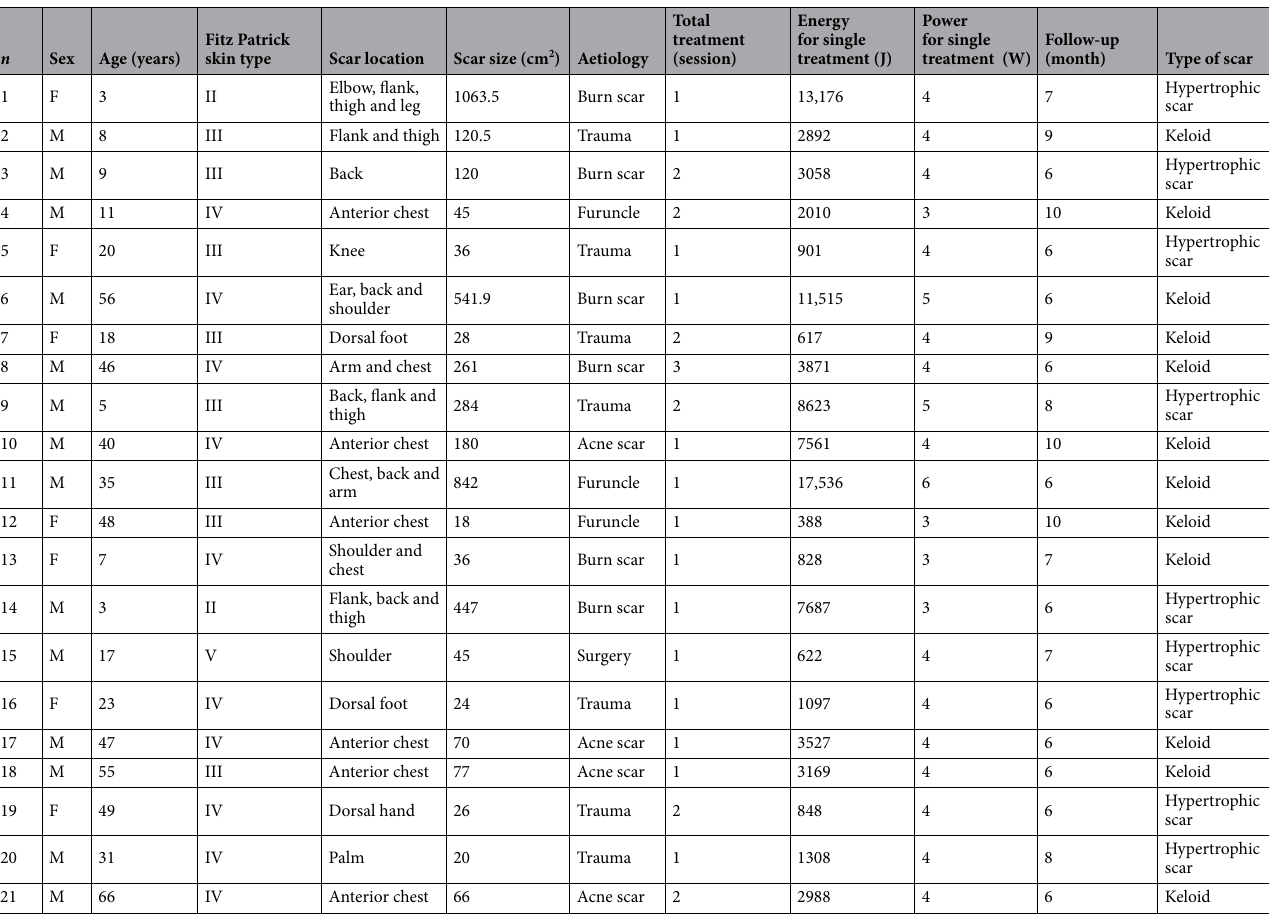
Table 1. Patient characteristics.